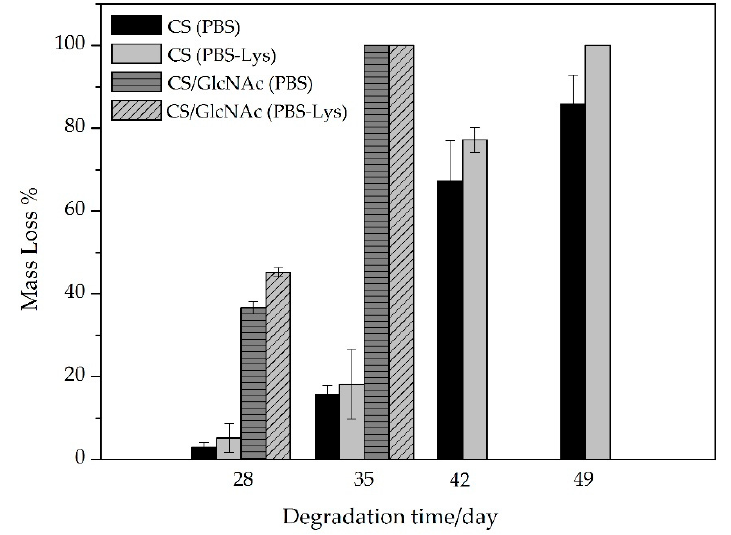
Figure 5. Mass loss of CS and CS/GlcNAc filaments as a function of the degradation time.